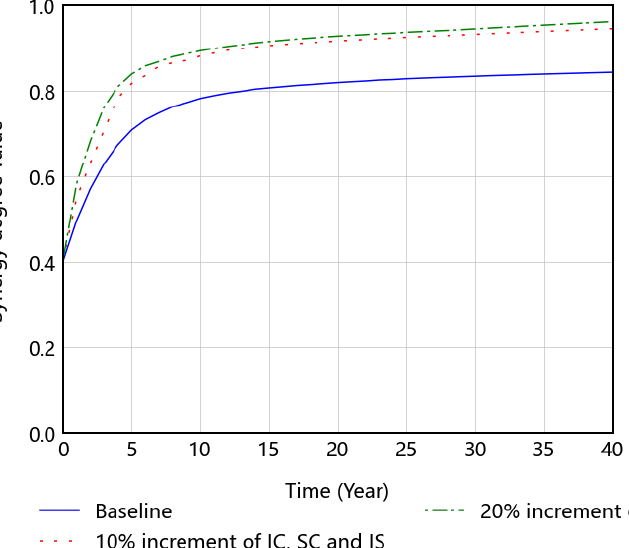
Figure 19. The effects of different degrees of IC, SC, and IS on synergy.